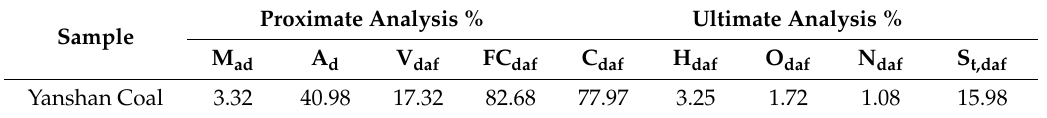
Table 1. Proximate and ultimate analysis of the coal sample.